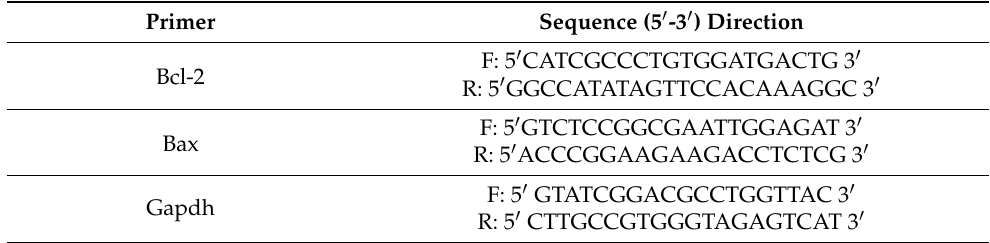
Table 1. Details of NCBI reference sequence of the three sets of primers of Bcl-2, Bax and